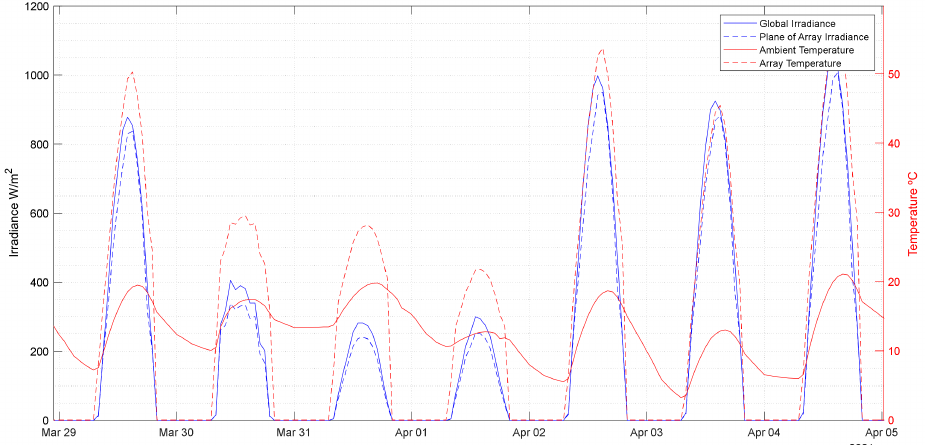
Figure 1. Environmental variables in PVSYST: irradiances (global horizontal and in plane of array) and temperatures (ambient and array). Note that the array temperature is not calculated when the irradiance is